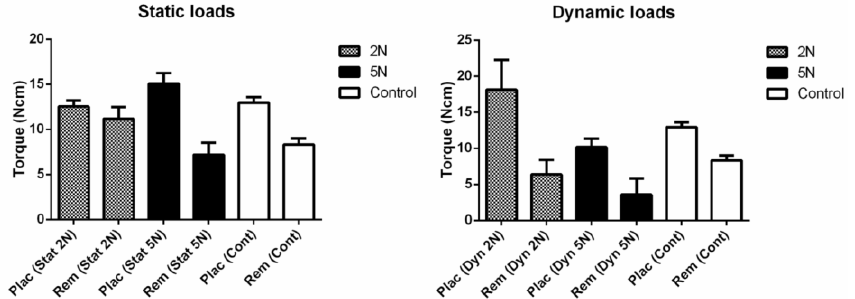
Figure 3. Mean peak torque values (Ncm) after static and dynamic loads cycles. The control group showed placement torque to identify any influence of pig rib bones on stability of the different screws evaluated.